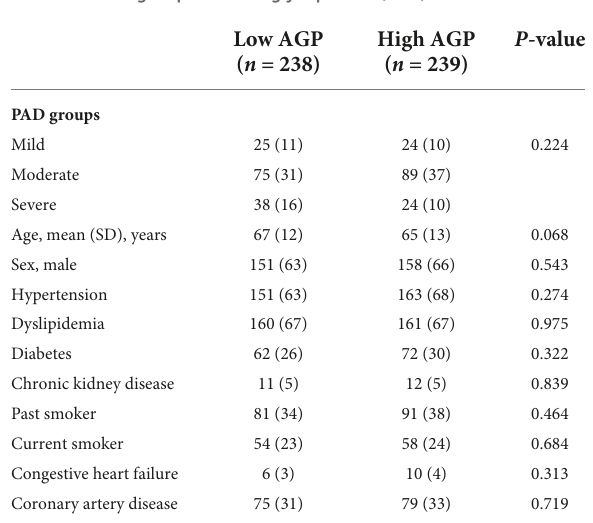
TABLE 4 Baseline demographic and clinical characteristics in patients with low and high alpha-1-acid glycoprotein (AGP)